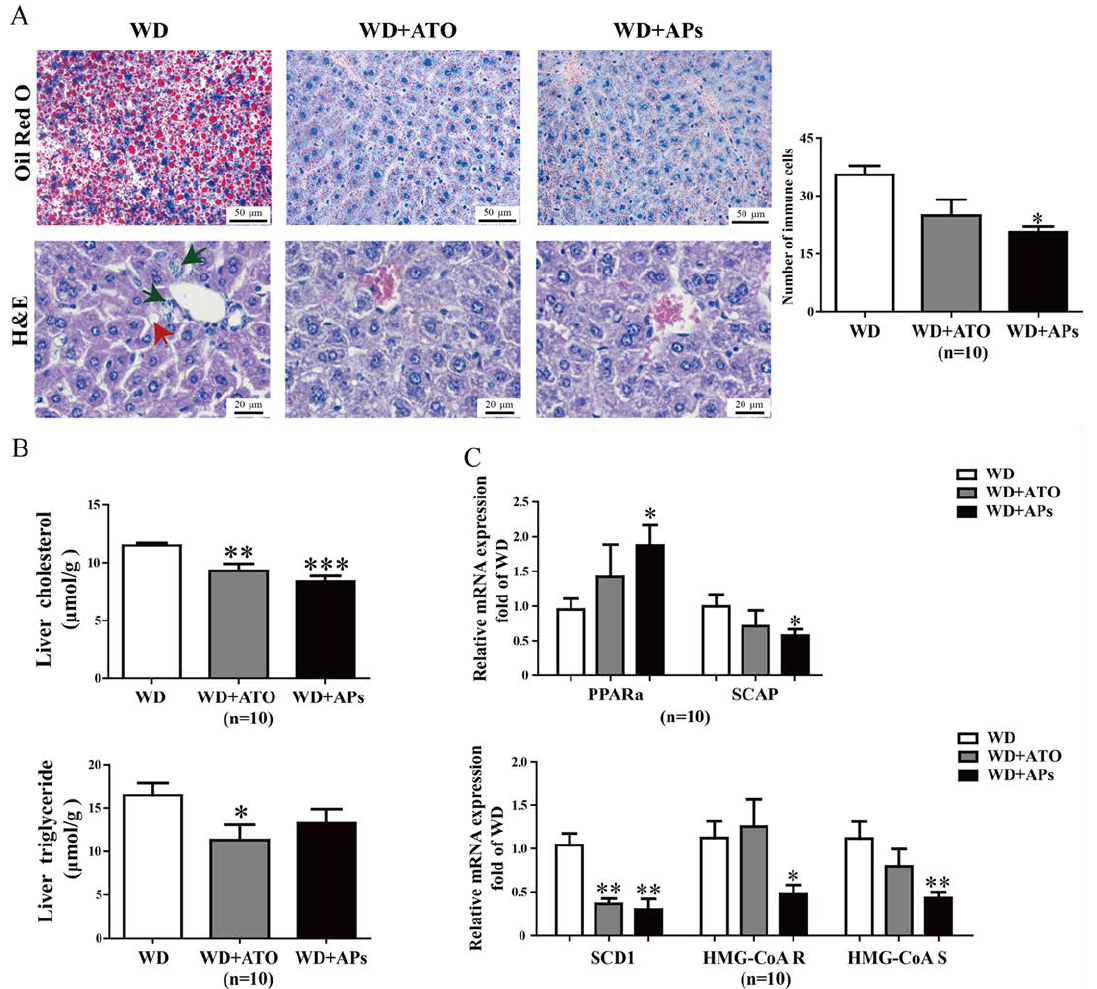
Figure 3. The APs attenuate hepatic lipid deposition, lipogenesis and inflammatory cell infiltration in the livers of WD-fed ApoE −/− mice. A : Hepatic lipid deposition was measured in WD-fed ApoE −/− mice treated with APs (100 mg/kg/day) or ATO (10 mg/kg/day) for 12 weeks. Microscopic examination of Oil Red O and H&E stained-liver sections revealed decreased accumulation of neutral fat and steatosis in the APs- or ATO-treated mice compared to the WD model mice. The red arrow shows the steatosis in the liver, and the black arrow shows the infiltration of inflammatory cells; B : Hepatic TG and total cholesterol levels were measured in the ApoE −/− mice fed with WD, WD + ATO, or WD + Aps; C : mRNA levels of the hepatic genes— SCAP , PPARα , SCD-1 , HMG-CoA R and HMG-CoA S were determined by real-time PCR. These genes are involved in lipid metabolism. The values are presented as the means ± S.E.M, n = 10 per group. * p < 0.05, ** p < 0.01, *** p < 0.001 vs. WD mice.